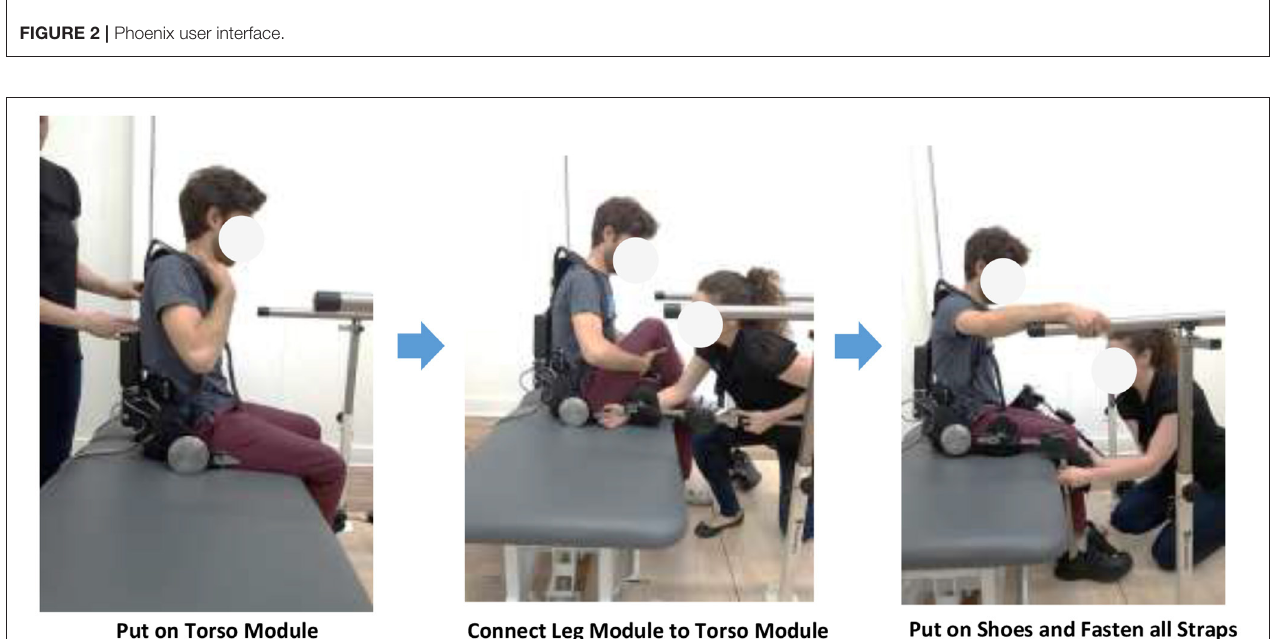
FIGURE 3 | Putting on the Phoenix